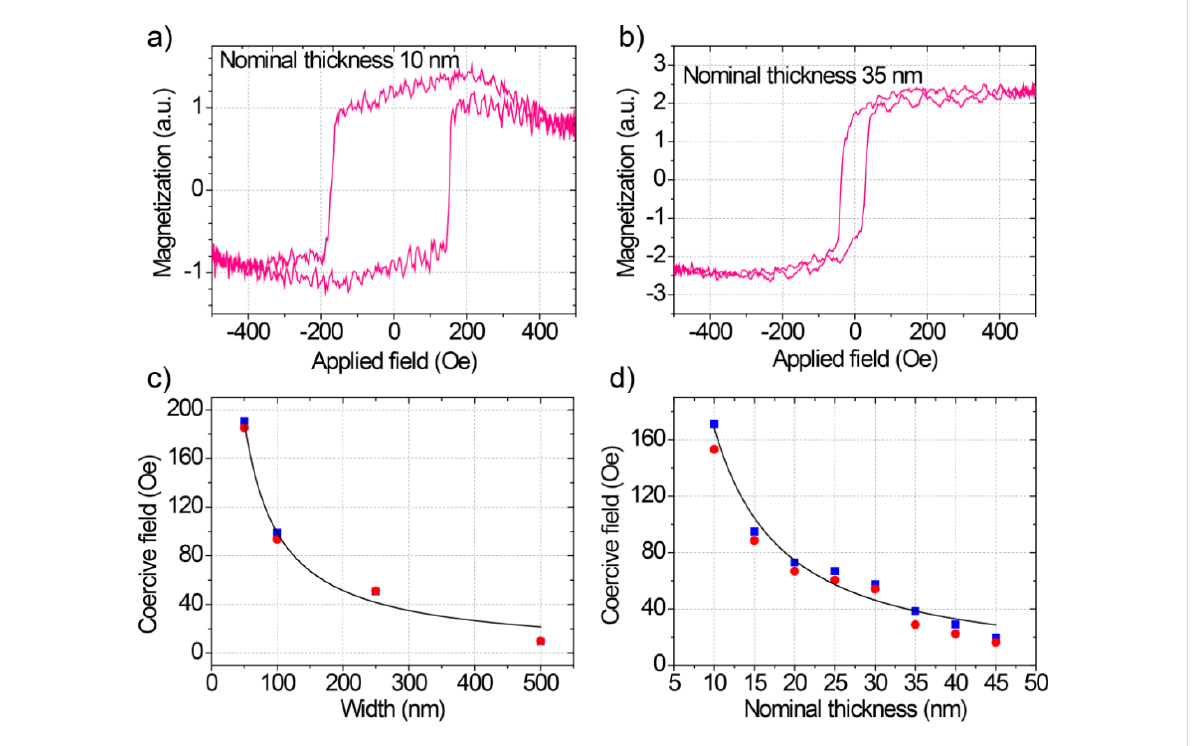
Figure 2: MOKE results. (a) Average magnetic hysteresis loop of the sample with width/nominal thickness of 250 nm/10 nm. (b) Average magnetic hysteresis loop of the sample with width/nominal thickness of 250 nm/35 nm. (c) Coercive field as a function of width for batch 1 ( t Nom = 25 nm) with positive and negative applied magnetic field (blue squares and red circles respectively). Please, be aware that the red circles partially hide the blue squares. The line is a fit to Equation 1. (d) Coercive field as a function of t Nom for batch 2 (width = 250 nm) with positive and negative applied magnetic field (blue squares and red circles respectively). The line is a visual